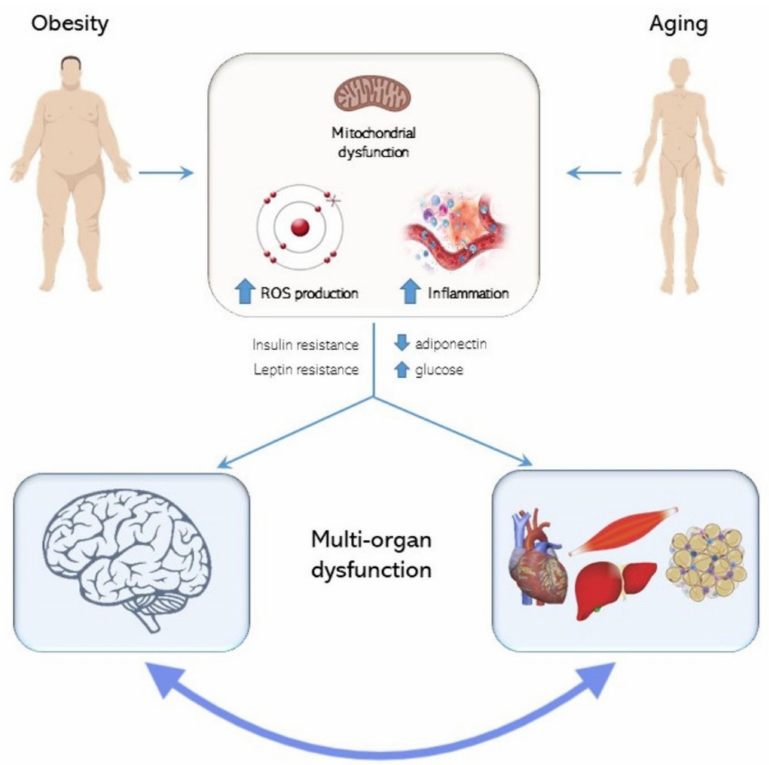
Figure 3. Chronic overnutrition and aging negatively a ff ect peripheral organs and the central nervous system by mitochondria dysfunction, increased oxidative stress and inflammation. The metabolic alterations associated with obesity include insulin and leptin resistance, decreased adiponectin and increased glucose